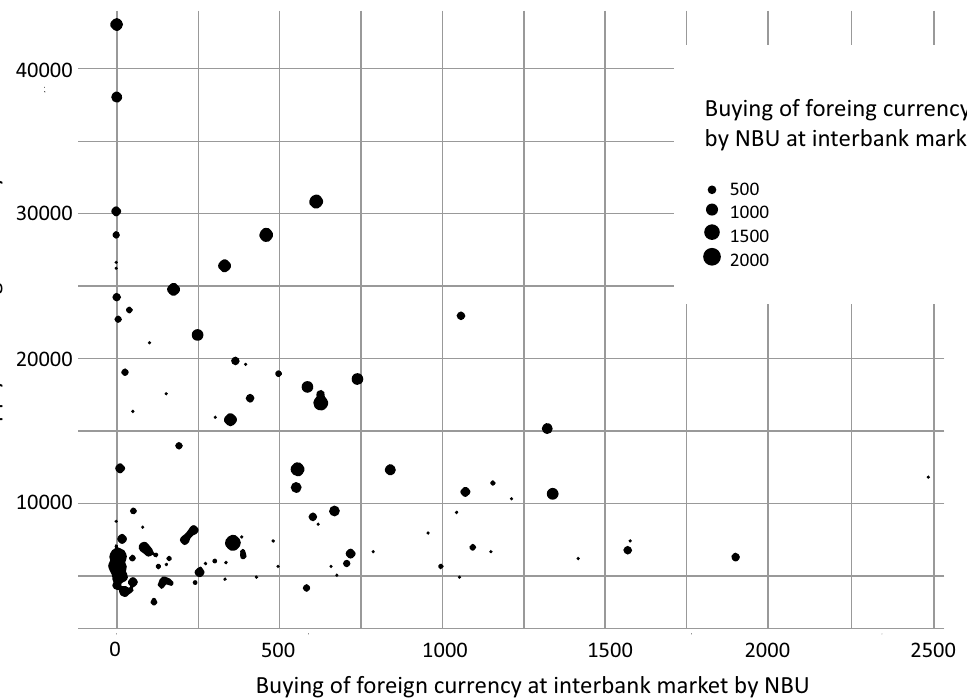
Figure 2. Influence of NBU intervention on supply of non-cash foreign currency in Ukraine, in ths dollars